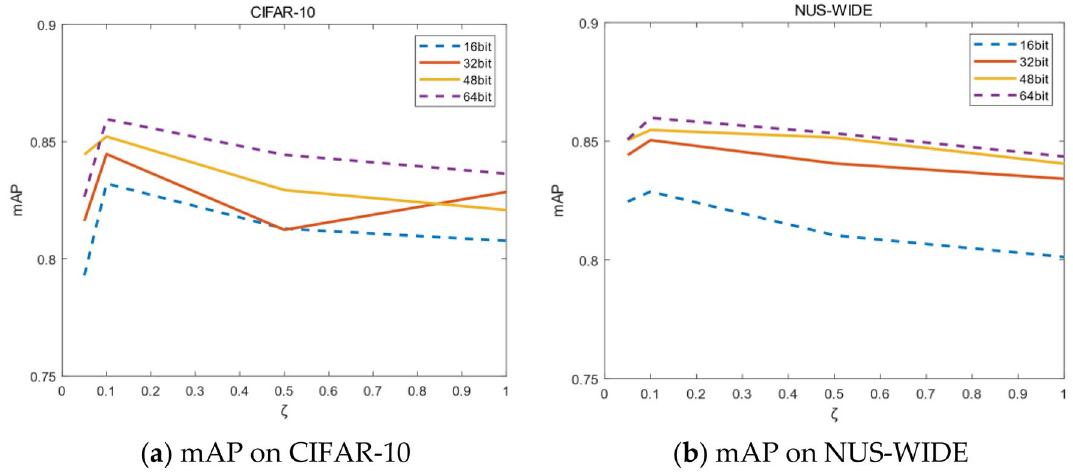
Figure 4. ( a,b ) Represent mAP on different ζ . (Created by “matlab R2019a” url: https:// ww2. mathw orks. cn/ produ cts/ matlab. html).